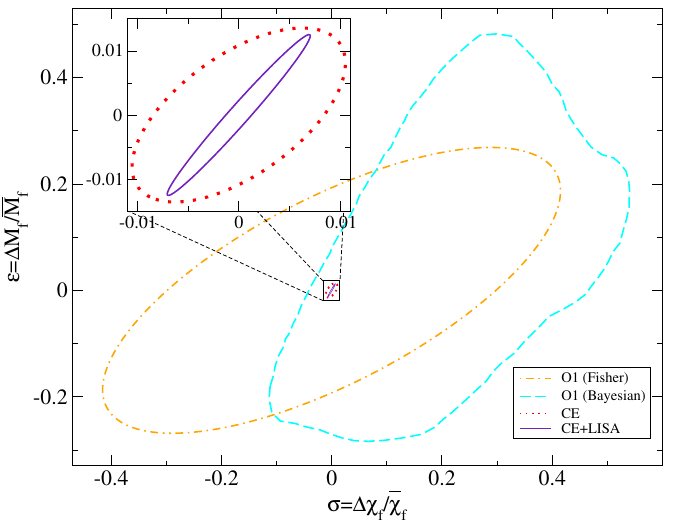
Figure 4. The 90% credible region contours of the transformed probability distributions in the (cid:101) − σ plane, describing the consistency of the remnant mass and spin general relativity (GR) predictions between the inspiral and merger-ringdown waveforms for GW150914-like events. Here we display the results for LIGO O1 (Fisher [87,88] and Bayesian [17] for comparison), CE, and the multi-band observation of CE and LISA. The areas of such confidence regions are displayed in Table 2, and show the following: (i) good agreement within ∼ 10% between the Fisher and Bayesian analyses, (ii) three orders-of-magnitude improvement from LIGO O1 to CE, and (iii) up to an additional order-of-magnitude improvement with multi-band observations. This figure is taken and edited from